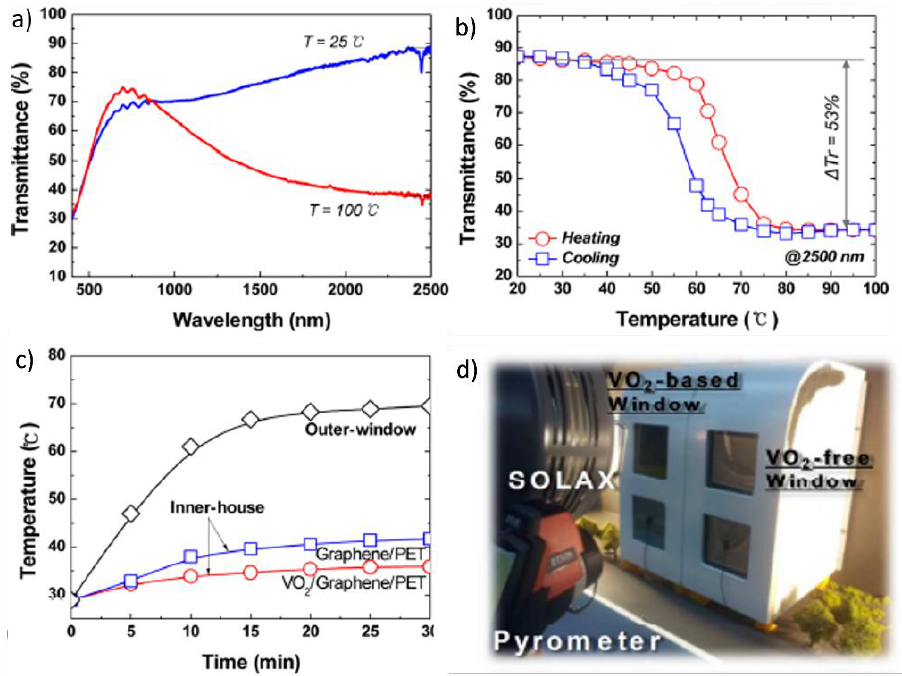
Figure 7. ( a ) Transmission spectra of VO 2 /graphene/polyethylene terephthalate (PET) film at 25 and 100 °C; ( b ) Temperature-dependent transmittance of VO 2 /graphene/PET film at 2500 nm; ( c ) Indoor temperature of a model house with VO 2 /graphene/PET films; ( d ) Photograph of a model house coated with VO 2 /graphene/PET films (VO 2 -based windows) and graphene/PET films (VO 2 -free windows). Reproduced with permission from [98] . Copyright 2013, American Chemical Society.